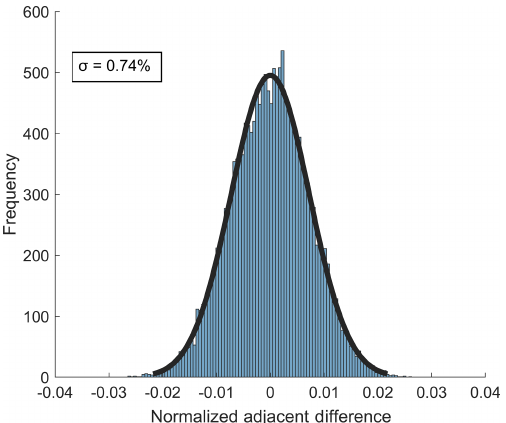
Figure 7. Distribution of normalized adjacent differences measured at 10Hz during a stable 27min ambient sampling period of 38ppbv O 3 from Scripps Pier. The 1 σ value of the distribution gives an upper limit of instrument precision of